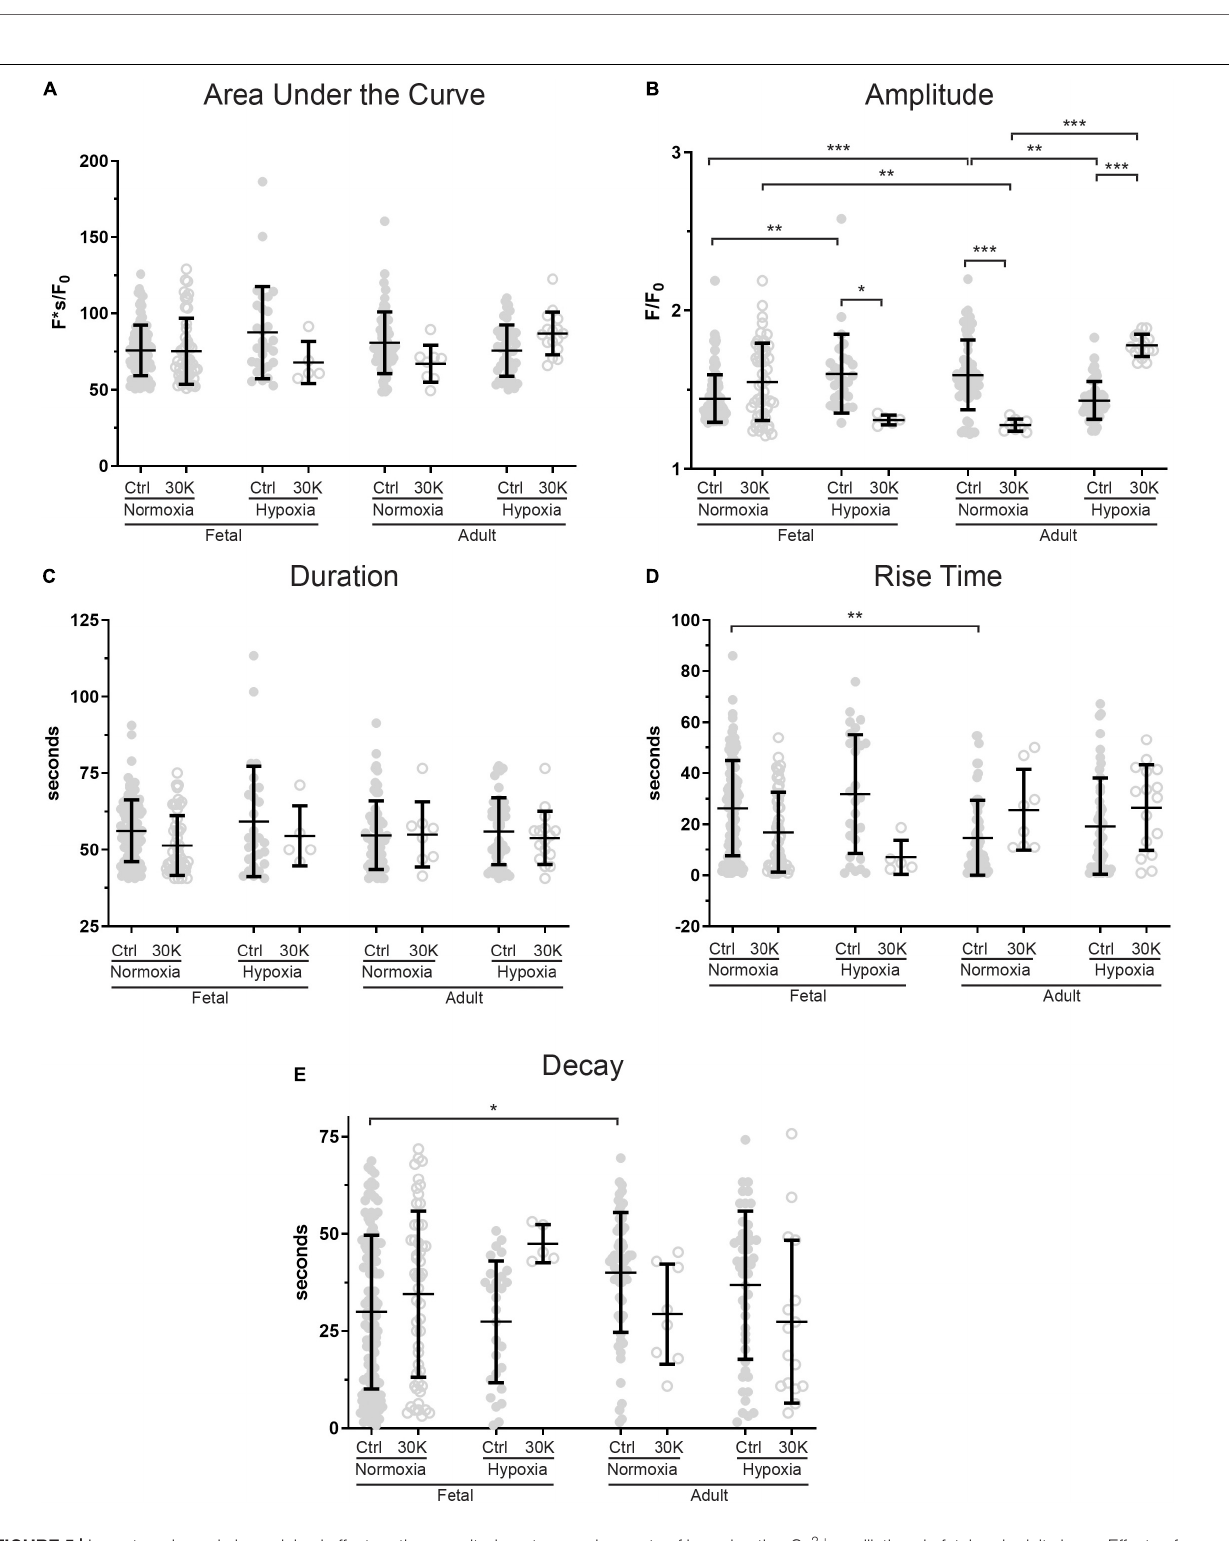
Frontiers in Physiology |